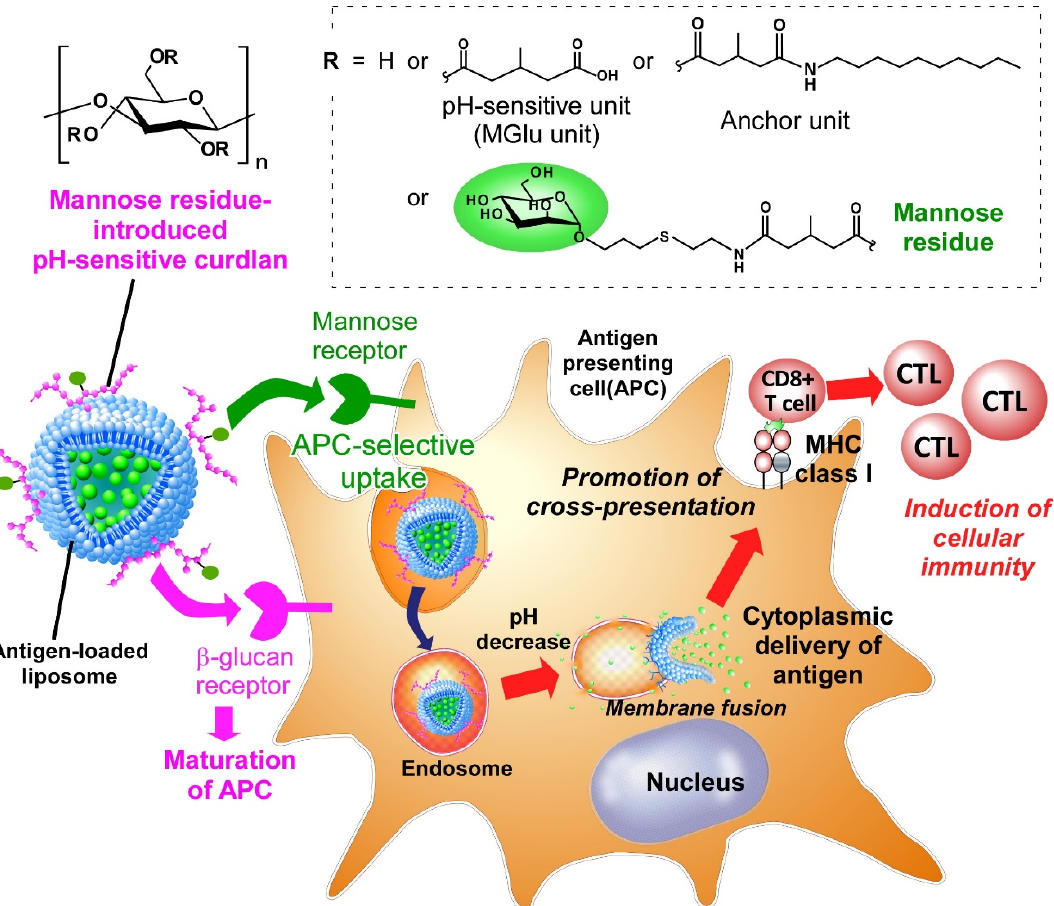
Figure 1. Design of mannose residue-introduced pH-responsive curdlan-modified liposomes for targeting to antigen presenting cell and cytoplasmic delivery of antigen towards induction of cross-presentation and cellular immunity.